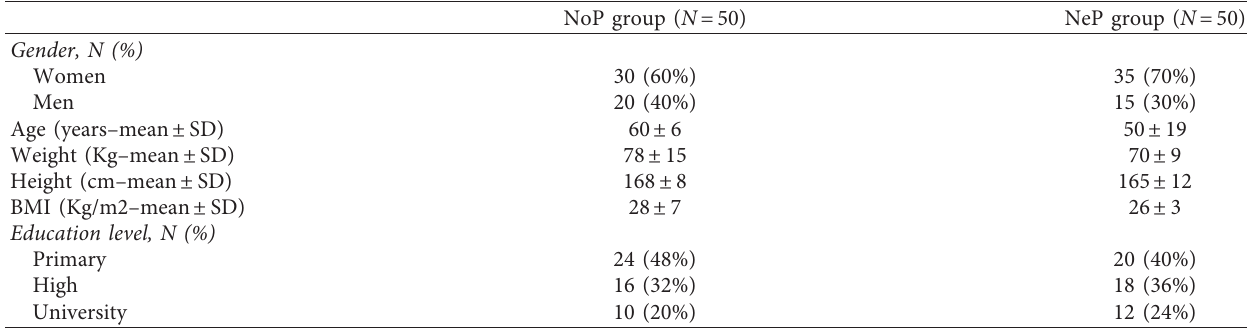
Table 1: Baseline demographic data according to pain reference diagnosis.